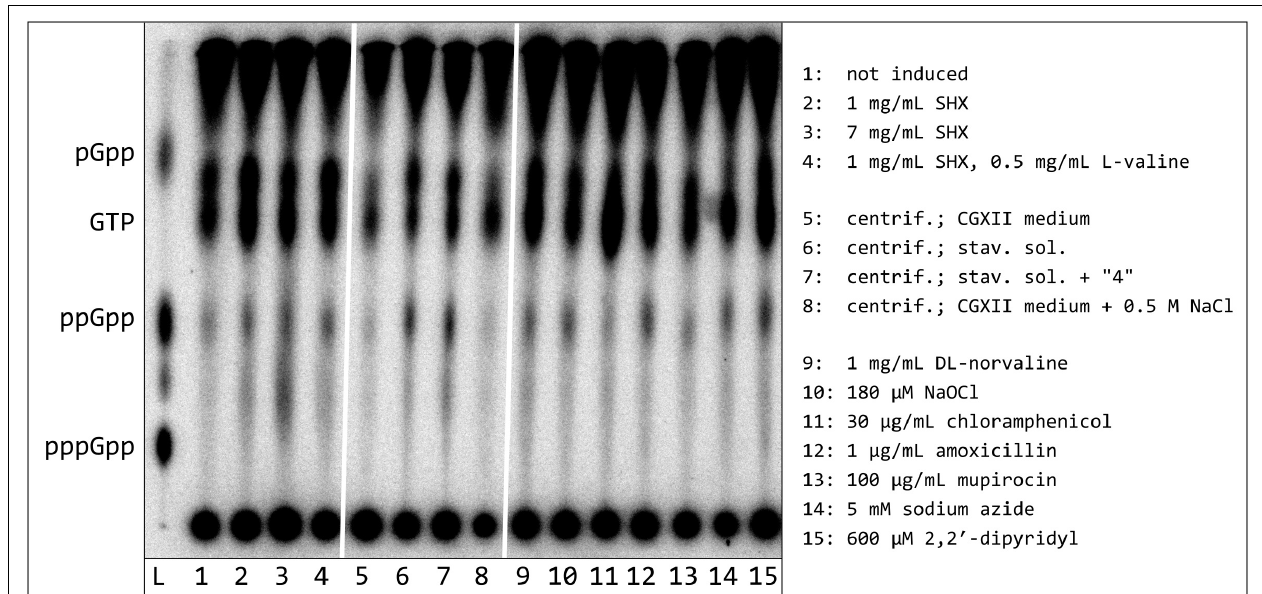
FIGURE 2 | Synthesis of hyperphosphorylated nucleotides in C. glutamicum after treatment with various stressors or exposure to nutrient deficiency. C. glutamicum cells were labeled in CGXII medium (low P), containing all proteinogenic amino acids (50 mg/L each), for 3 h with 54 µ Ci/ml [ 32 P]orthophosphate. The cultures were treated with the indicated stressors, respectively centrifuged and subsequently resuspended in starvation solutions, as specified. All samples were further incubated for 30 min. For nucleotide extraction, the cell pellets were resuspended in 6 M formic acid, shock-frozen in liquid nitrogen and subjected to five freeze-thaw cycles. 1.5 µ L of the clarified supernatant were applied to PEI cellulose TLC-plates and developed in 1.5 M KH 2 PO 4 solution (pH 3.4). 32 P-labeled pGpp, ppGpp. and pppGpp standards were prepared enzymatically by RelS catalyzed pyrophosphorylation of GMP, GDP, and GTP using [ γ - 32